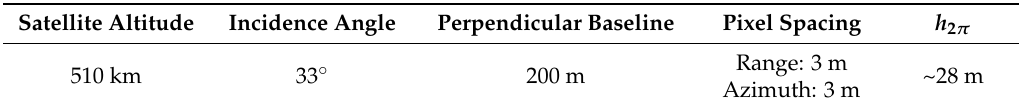
Table 3. Parameters for TerraSAR-X data simulation.